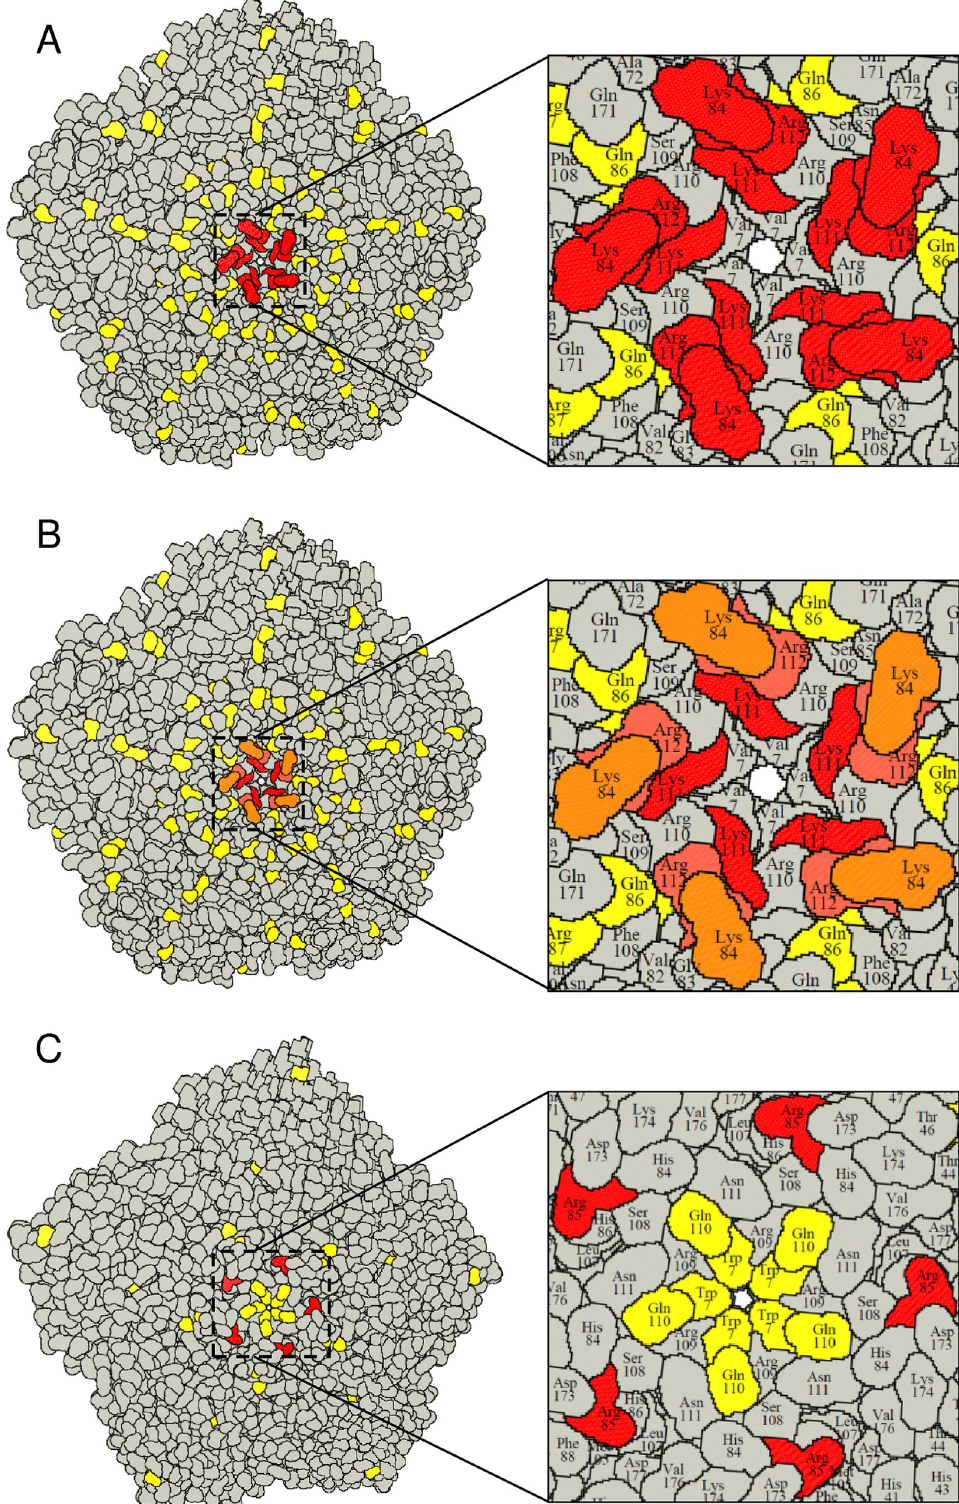
Fig 1. A RIVEM representation [40] of the SAT1 and SAT2 pentamers. ( A ) The SAT1 and SAT2 pentamers are based on the protein data bank co-ordinates 2WZR and 5ACA, respectively. Amino acid substitutions observed during